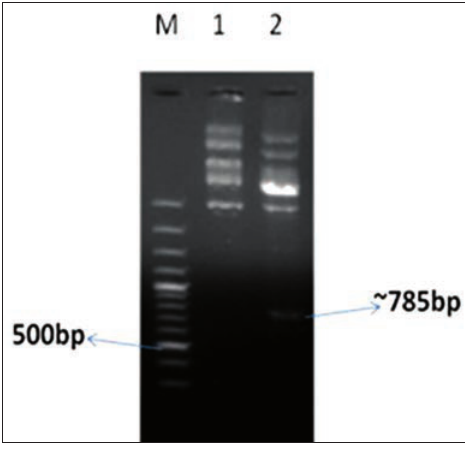
Figure-3: Restriction endonuclease analysis of recombinant plasmid, Lane M: 100bp ladder, Lane 1: Undigested recombinant plasmid, Lane 2: Bam HI and Sac I double digested recombinant plasmid